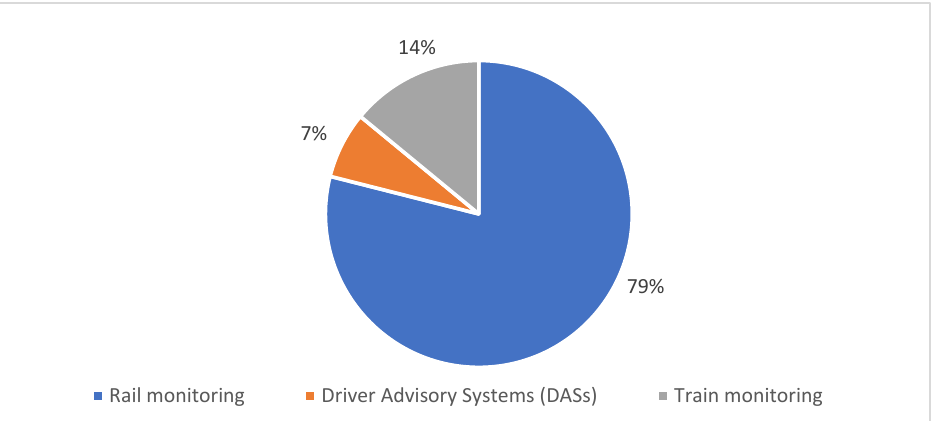
Figure 5. Distribution of the selected papers by monitoring domain.